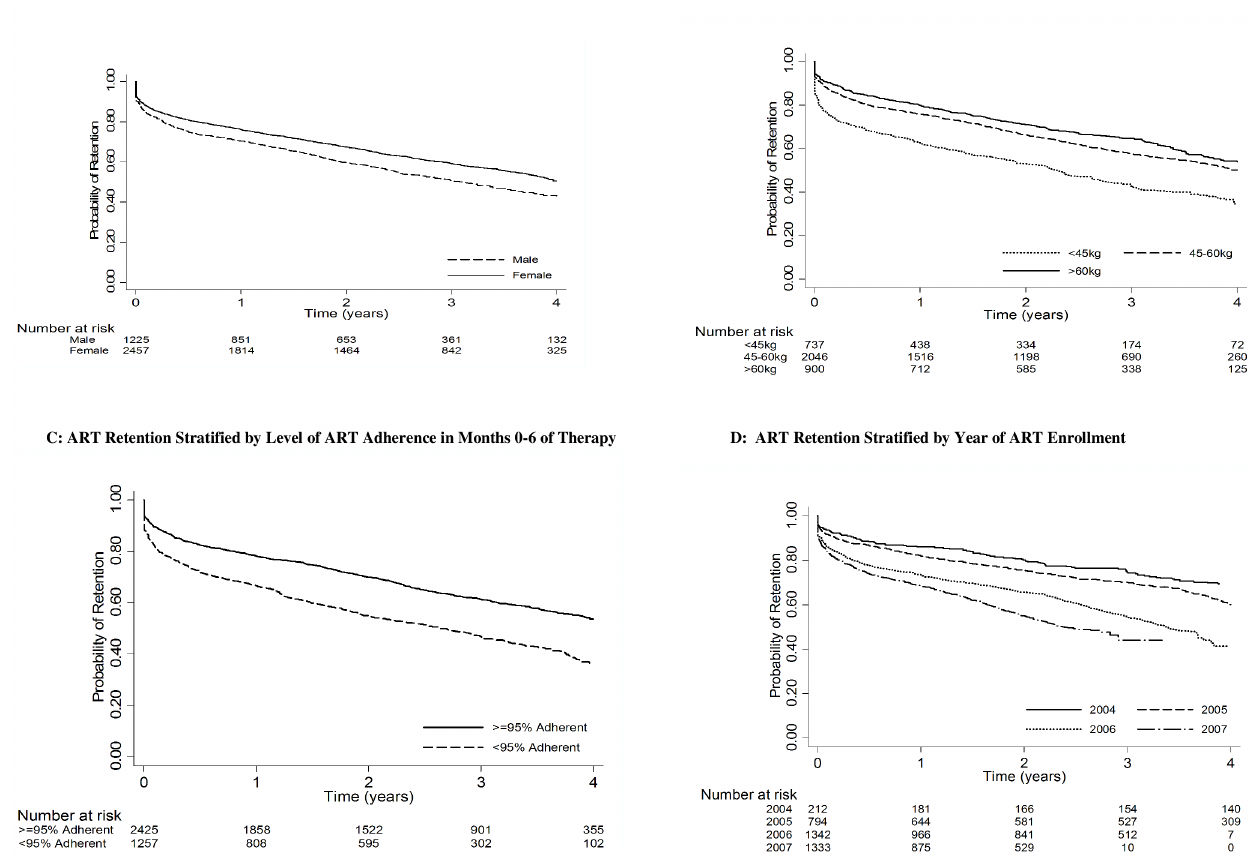
Figure 2. Kaplan-Meier Curves Showing Retention among Adults Initiating ART in Coˆte d’Ivoire during 2004–2007 Stratified by Risk Factors for Attrition.